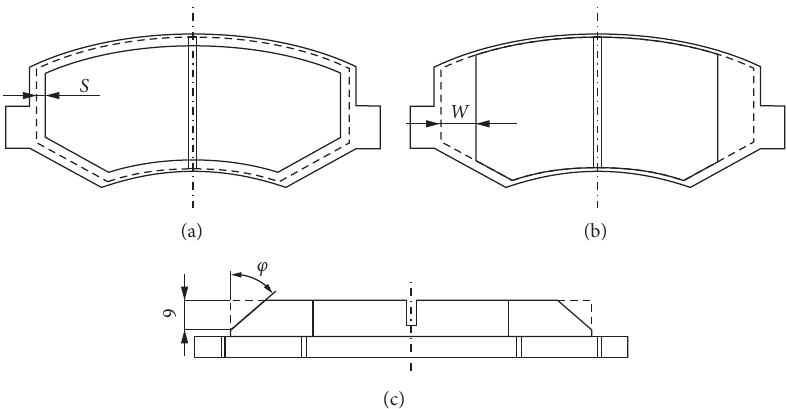
Figure 5: Methods of adjusting the compressive strain by modifying the brake lining: (a) narrowing the section outline; (b) reducing the lining width; (c) chamfering the brake pads.